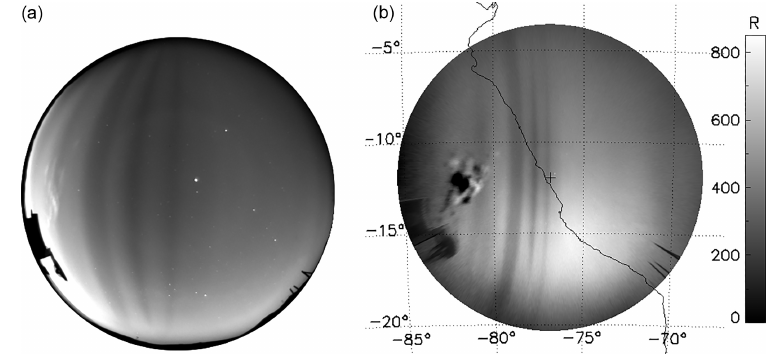
Figure 2. (a) A raw image at 05:18UT on 3 April 2014 from the Jicamarca ASI. The exposure time is 120s and the image was obtained using a 6300Å filter. Clouds are visible on the left edge of the image. (b) The unwarped image. The top of the image is north and the left of the image is west. The western coast of South America is seen as a black line and the location of the ASI is marked with a small black cross. The dotted lines are geographic latitudes and longitudes. Latitude and longitude are determined for each pixel, and the image is transferred to a map projection. The grayscale shows the brightness in rayleighs. Clouds low on the horizon are now more prominent in the unwarped image. They also contain dark areas due to background subtraction.